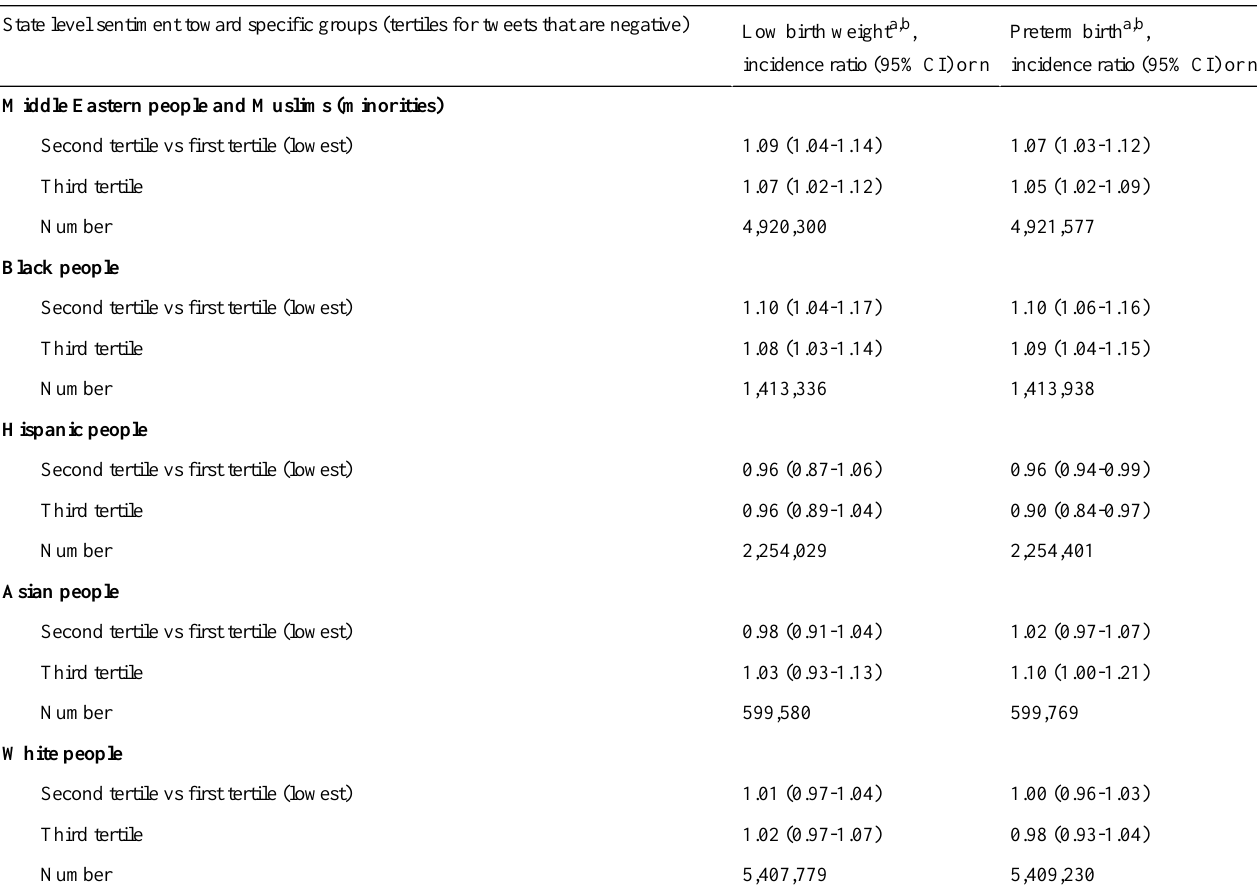
Table 5. Stratified analyses of associations between state-level sentiment and birth outcomes among subgroups. level sentiment toward specific groups (tertiles for tweets that are negative)